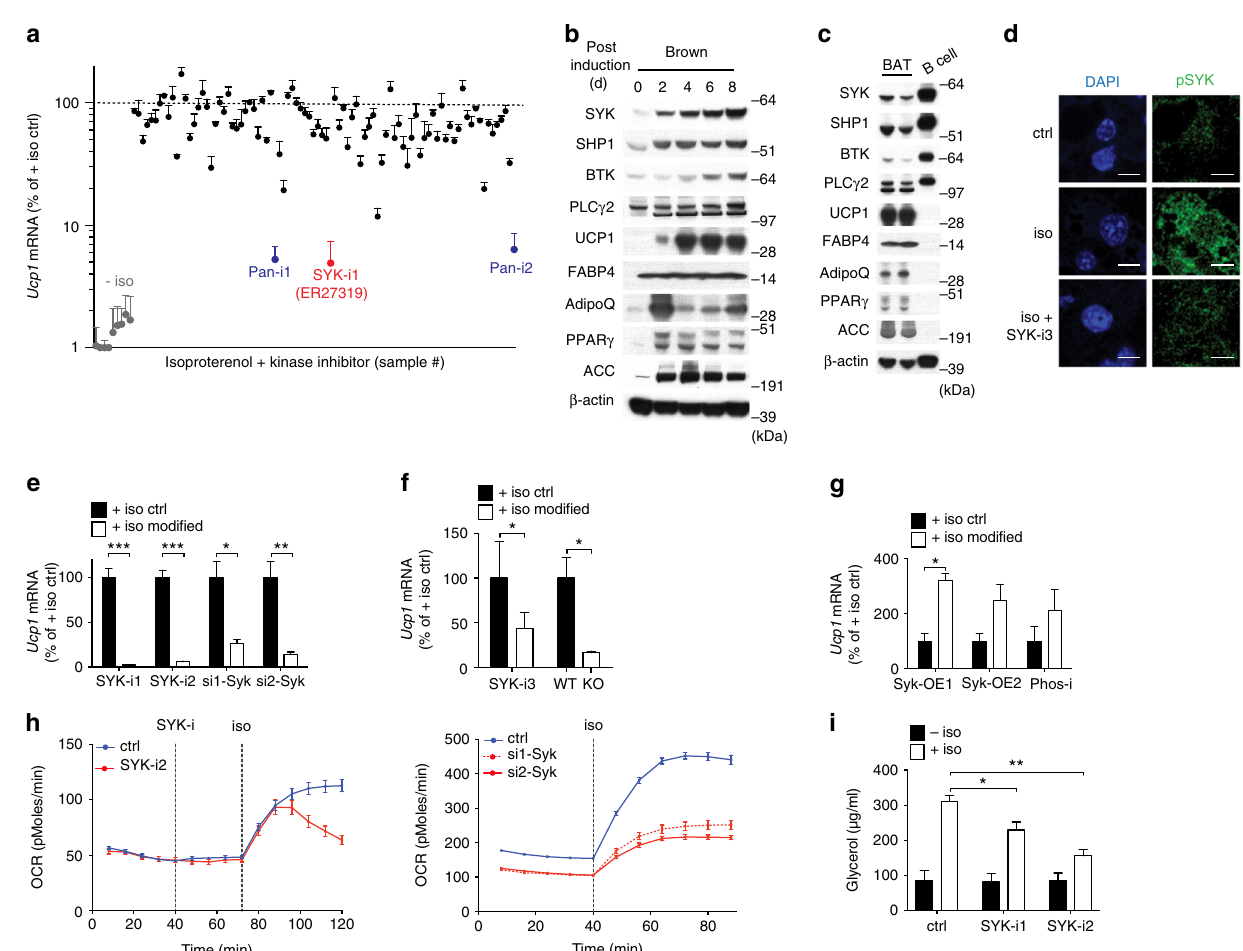
Fig. 1 Identi fi cation of kinases regulating Ucp1 expression in response to β -adrenergic stimulation. a Screening of a kinase inhibitor library ( n = 90) to identify small molecules modulating Ucp1 RNA expression in response to stimulation with isoproterenol in in vitro differentiated day 8 immortalized brown adipocytes. Blue, pan-kinase inhibitors; red, SYK inhibitor ER27319; dotted line denotes + isoproterenol control ( n = 3). b Representative immunoblots of two independent in vitro differentiations of primary brown adipocytes ( b ) and of two independent BAT isolations with two mice each ( c ) of SYK and pathway members as well as brown adipocyte markers. d Immuno fl uorescence of primary brown adipocytes stimulated with isoproterenol in the absence or presence of 2 µ M SYK-i3 (R406), one representative IF of fi ve independent replicates is shown. Scale bar = 10 µ m. e Ucp1 RNA expression after stimulation with isoproterenol of differentiated day 8 immortalized brown adipocytes pretreated with 10 μ M SYK inhibitors (SYK-i1 is ER27319; SYK-i2 is Bay 61-3606) or following transfection with siRNA targeting Syk mRNA 4 days prior (si1-Syk and si2-Syk) ( n = 3). f Isoproterenol-induced Ucp1 RNA expression in primary day 8 brown adipocytes in vitro pretreated with SYK-i3 (R406) or in primary day 8 brown adipocytes derived from CreERT2 Syk fl ox/ fl ox mice (KO) or Syk fl ox/ fl ox (WT) both treated with 4-hydroxy tamoxifen (4-OHT) one day prior to induction of differentiation ( n = 3). g Ucp1 RNA expression in primary day 8 brown adipocytes after overexpression of wild-type mouse SYK (Syk-OE1 and Syk-OE2) or pretreatment with 1 μ M phosphatase inhibitor 3AC and stimulation with isoproterenol ( n = 2). h Oxygen consumption rate (OCR) of immortalized brown adipocytes stimulated with isoproterenol and pretreated with 10 μ M (SYK-i2) or following siRNA mediated knock down of Syk 4 days prior to measurement (si1-Syk, si2-Syk). Results are shown as average OCR + SEM of 18 measurements per time point and representative of three replicates. i Cell culture medium glycerol content from immortalized brown adipocytes at day 8 treated with isoproterenol in the absence or presence of 10 µ M SYK-i2 ( n = 3). For a , e – g , mean % of iso stimulated control ± SEM. For e , g , i , two-tailed unpaired Student ’ s t test was performed (* P < 0.05, ** P < 0.005 and *** P < 0.0005). For f , two-tailed unpaired Student ’ s t test was performed on Log transformed